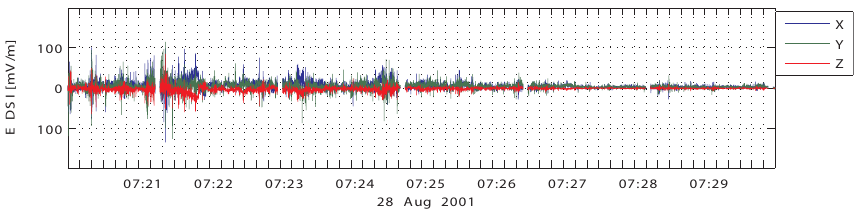
Fig. 10. A plot of EFW electric field intensity for C4 for the 3 spacecraft axes, with x and y nearly perpendicular to the magnetic field. The figure indicates rather significant perpendicular electric fields ( ∼ 100mV/m) near 07:20:20 UT and again centered near 07:21:20 UT.